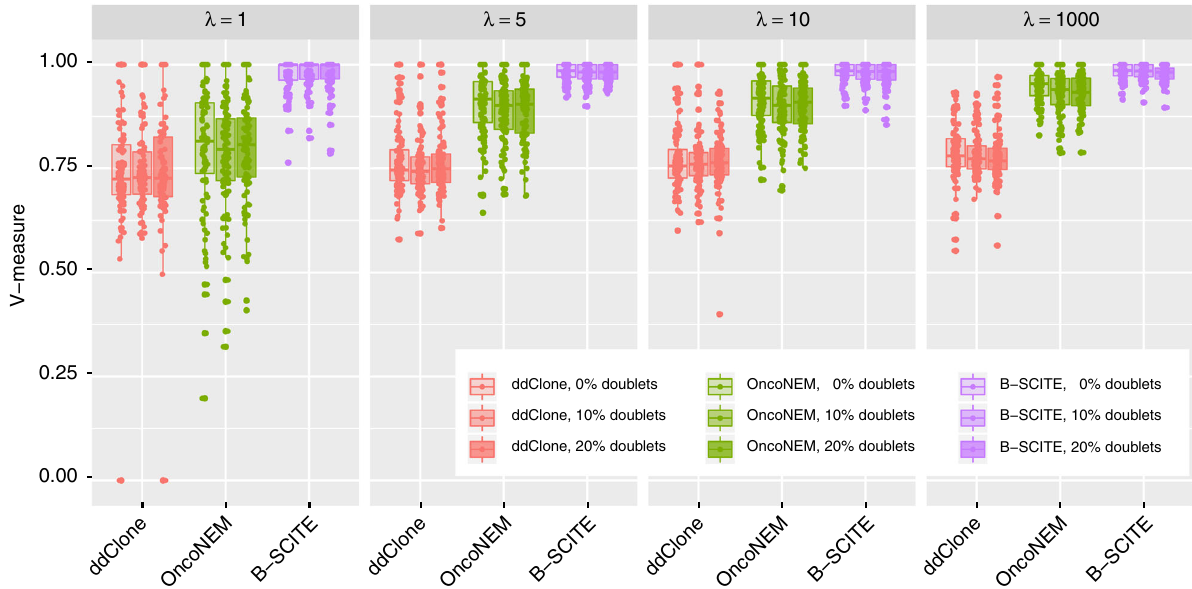
Fig. 3 Accuracy of mutation clustering by ddClone, OncoNEM and B-SCITE for 100 simulated clonal trees with 10 nodes (clones) and 50 mutations. For the single-cell data, we drew 25 genotypes from each clonal tree for various values of parameter λ , which controls bias in sampling single cells from clones (large values of λ indicate a small bias, where the probability of drawing a single cell from a given clone is usually close to its prevalence in the entire tumour cell population). We also added the following noise to the single-cell genotypes: false-positive rate 10 − 5 , false-negative rate 0.2, missing (NA) rate 0.05 and doublet rates 0, 0.1 and 0.2. Bulk data coverage was set to 10,000, and variant read counts drawn from a binomial distribution. We obtained data sets from trees for each parameter combination. A more detailed description of the simulation data is given in Supplementary Methods. For the de fi nition of V-measure see ref. 36 . Source data are provided as a Source Data fi